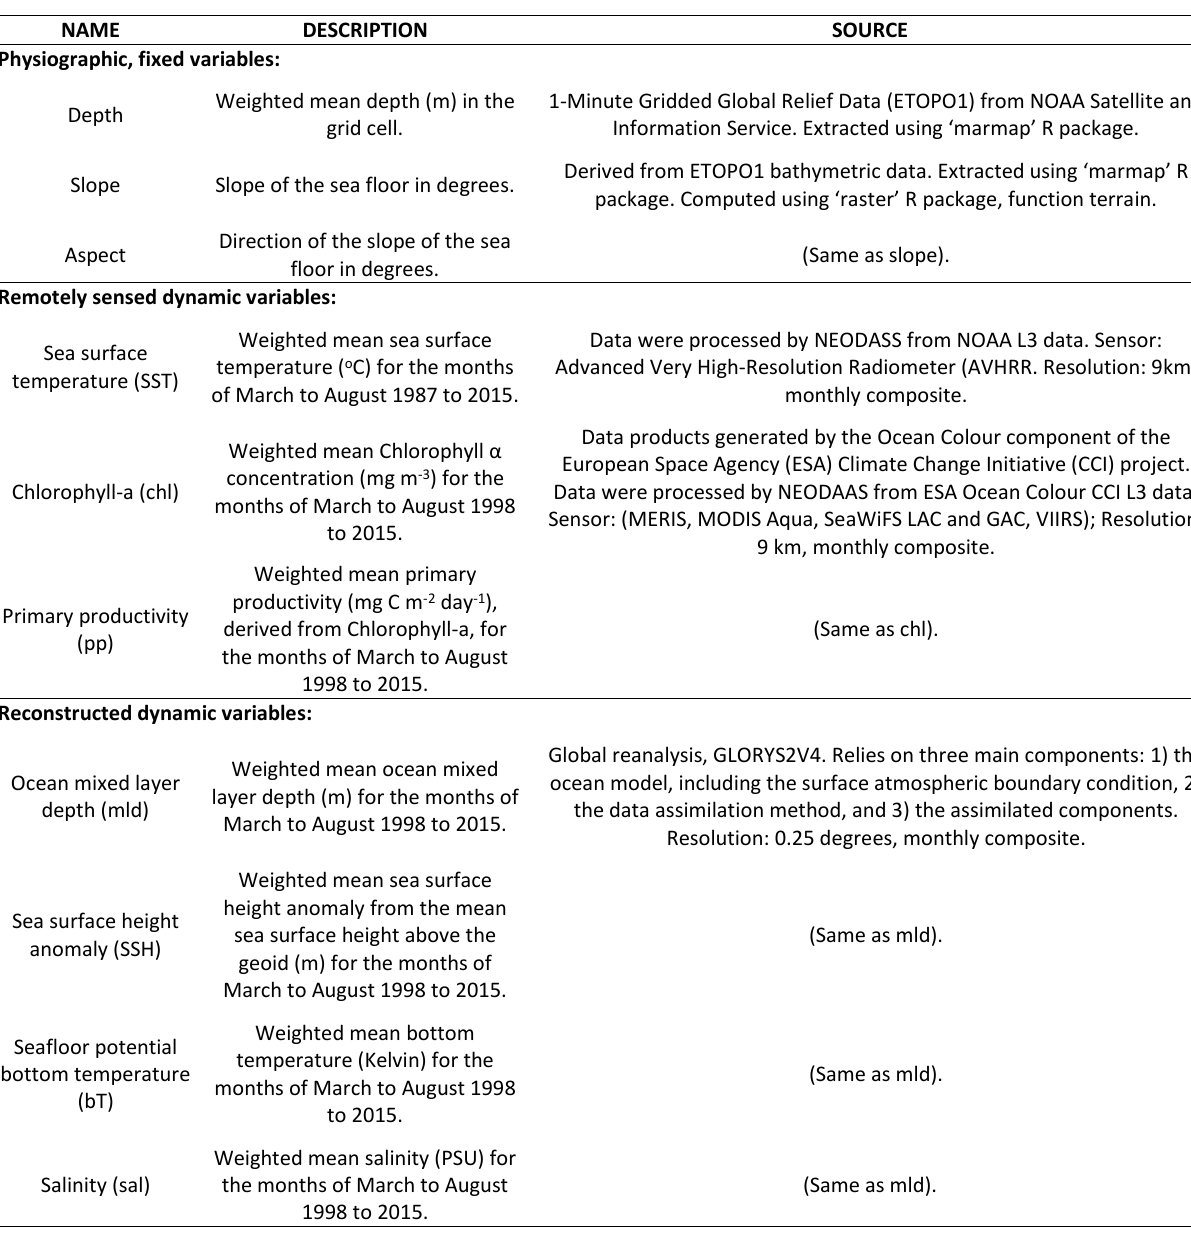
Table 2. Environmental variables, description, source and abbreviations used in modelling. (NOAA = National Oceanic and Atmospheric Administration; NEODAAS = NERC Earth Observation Data Acquisition and Analysis